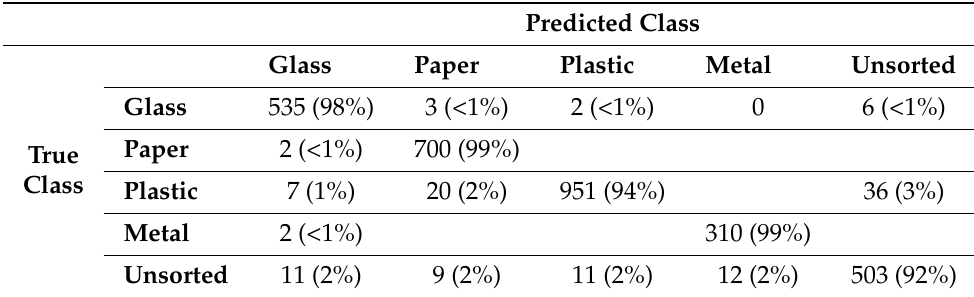
Table 5. Test confusion matrix obtained for hybrid classification with integration at prediction.